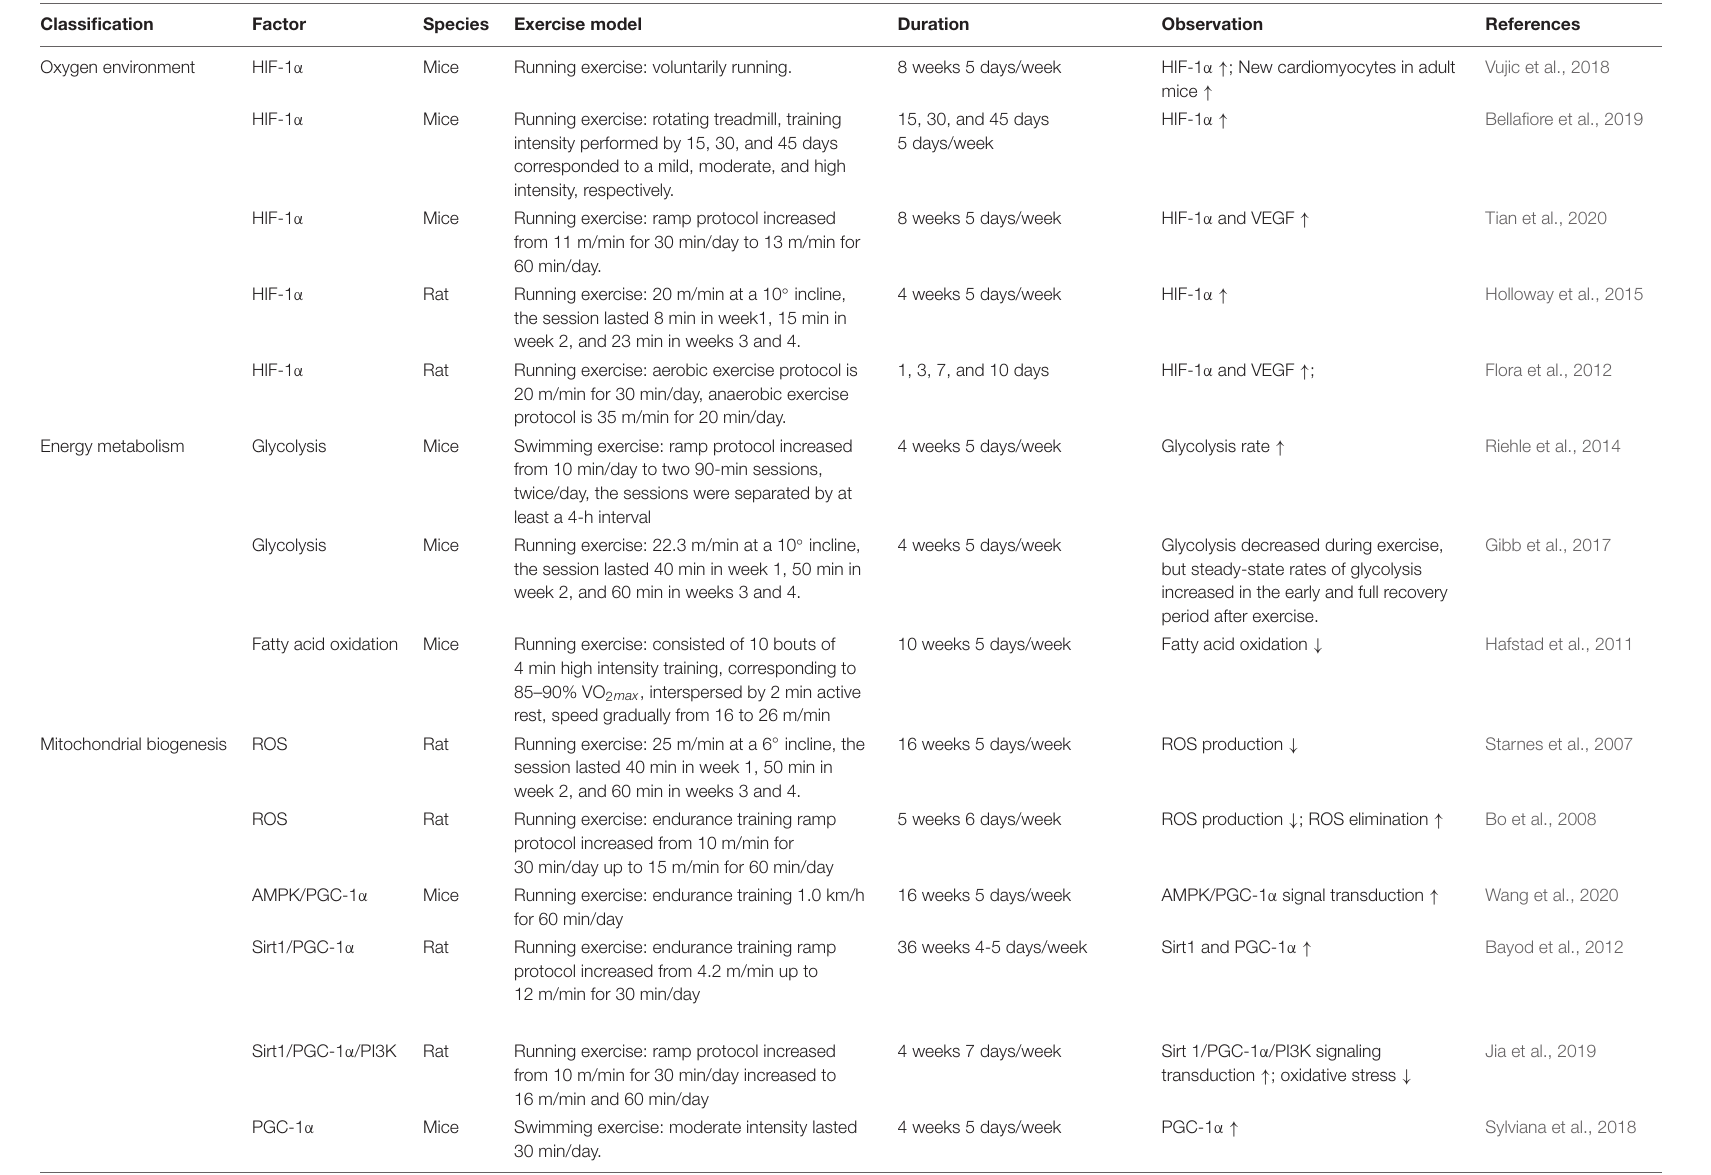
TABLE 1 | Factors related to oxygen mechanisms involved in exercise-induced cardiomyocyte regeneration.